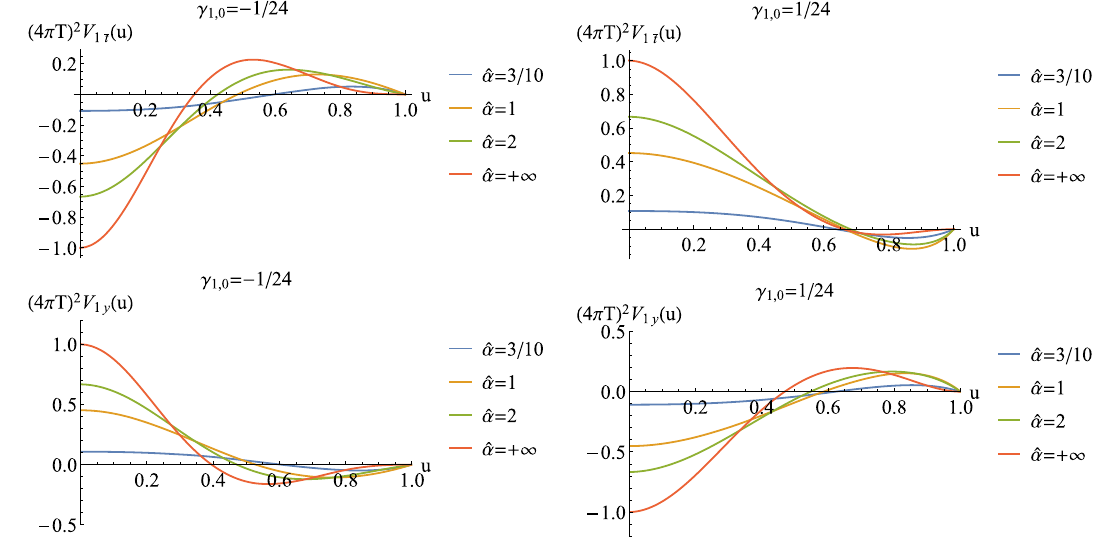
Fig. 16 The potentials V 1 ¯ t ( u ) (plots above) and V 1 y ( u ) (plots below) with different γ 1 , 0 and ˆ α